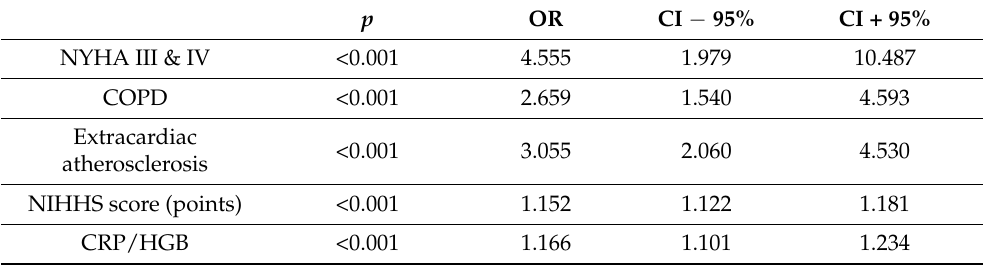
Table 5. Regression model for patients with pneumonia.